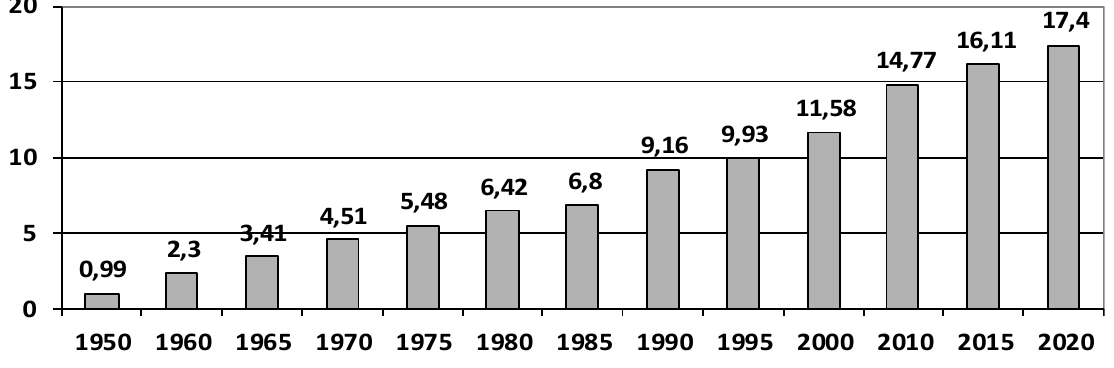
Figure 1: International Arrivals as a Percentage of World Population